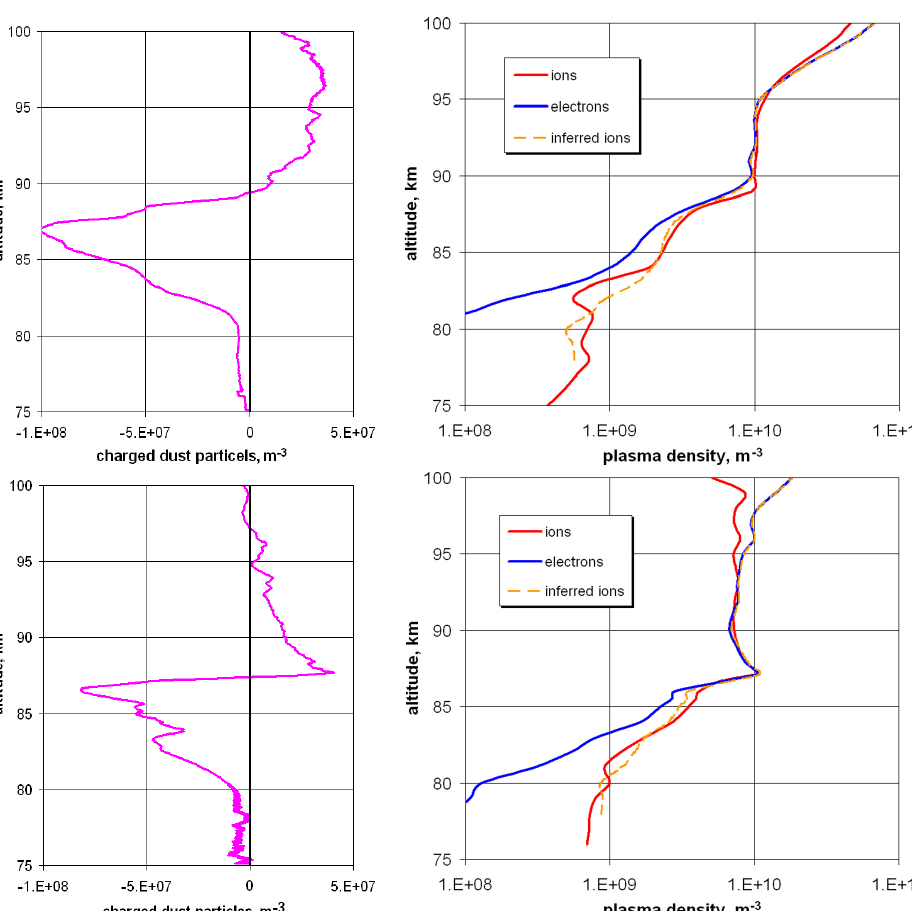
Fig. 6. As in Fig. 5, but for flight 8 (top) and 9 (bottom). Note again that the positive currents seen above 89 and 87km (ECOMA-8 and -9, respectively) are indications of incomplete shielding from positive ions and not signatures of positively charged particles (Rapp et al., 2012).